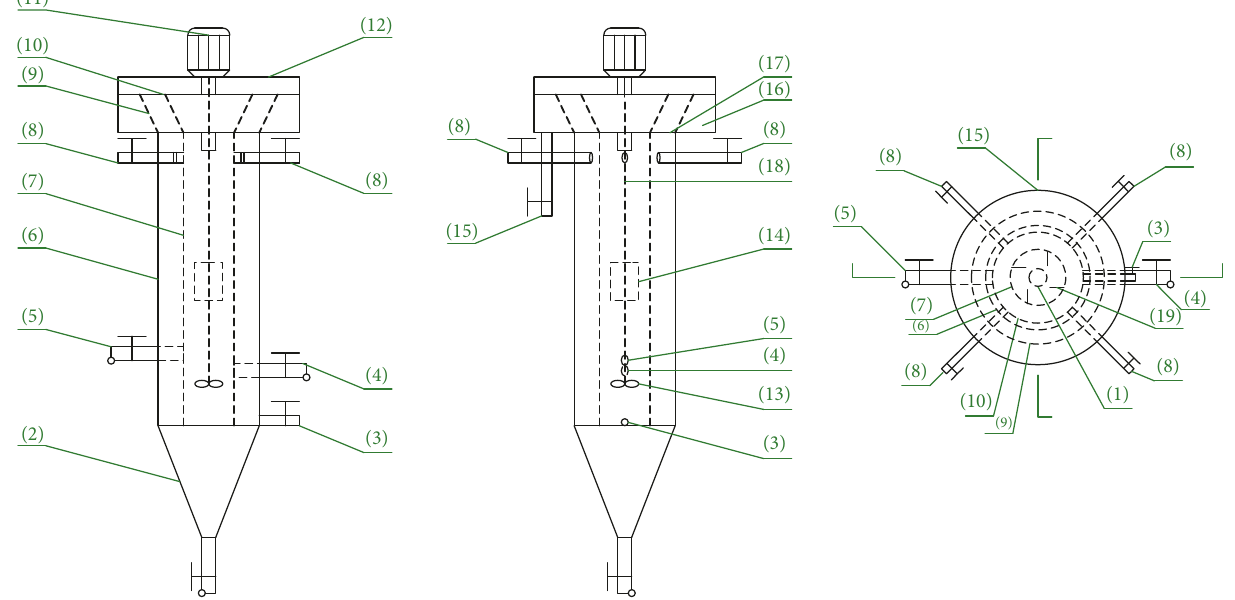
Figure 1: The schematic diagram of internal recycle reactor for phosphorus recovery. (1) Outlet of product; (2) collecting bowl for crystalline particle; (3) sampling port; (4) water inlet; (5) feed inlet; (6) outer tube; (7) inner tube; (8) reagent addition; (9) outer overflow nozzle; (10) internal overflow nozzle; (11) electrical machine; (12) mounting plate of electrical machine; (13) spiral stirrer; (14) rectangle stirrer; (15) water outlet; (16) effluent flume; (17) reflowing valve; (18) transmission shaft; (19) baffle of turbulent flow.